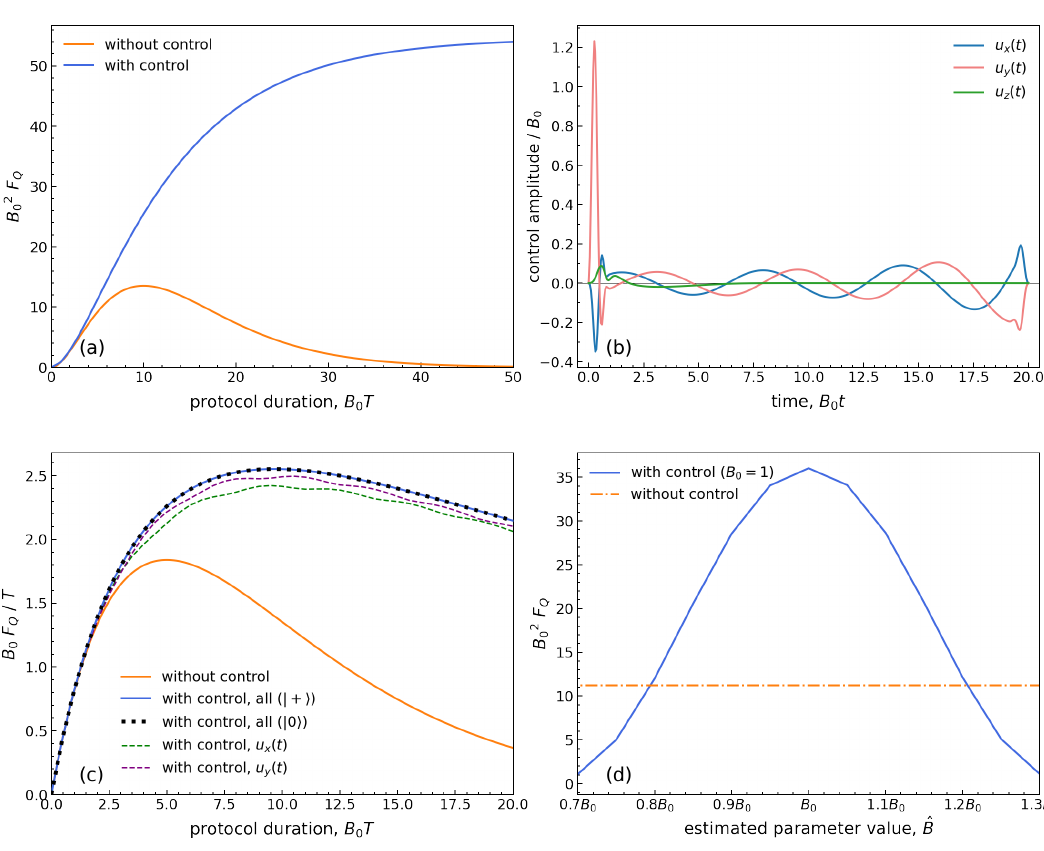
− 2 ) achieved = 1.0 (a) The QFI (in units of B Figure 3: Relaxation, γ − = 0.2, B 0 0 − 1 ). without control and with control optimised at different duration T (in units of B 0 (b) Optimal controls obtained using Krotov’s method for the dynamics with T = 20. (c) Normalised QFI (by T ) without control (orange line), with control in all directions using | + 〉 (purple line) or | 0 〉 (black dotted line) as probe and with control restricted ( t ) (green dashed line) or u ( t ) (red dashed line) (d) The QFI achieved to only u x y by applying controls optimised with different estimated parameter values ˆ B on states evolved under the true parameter value. The target time is T =